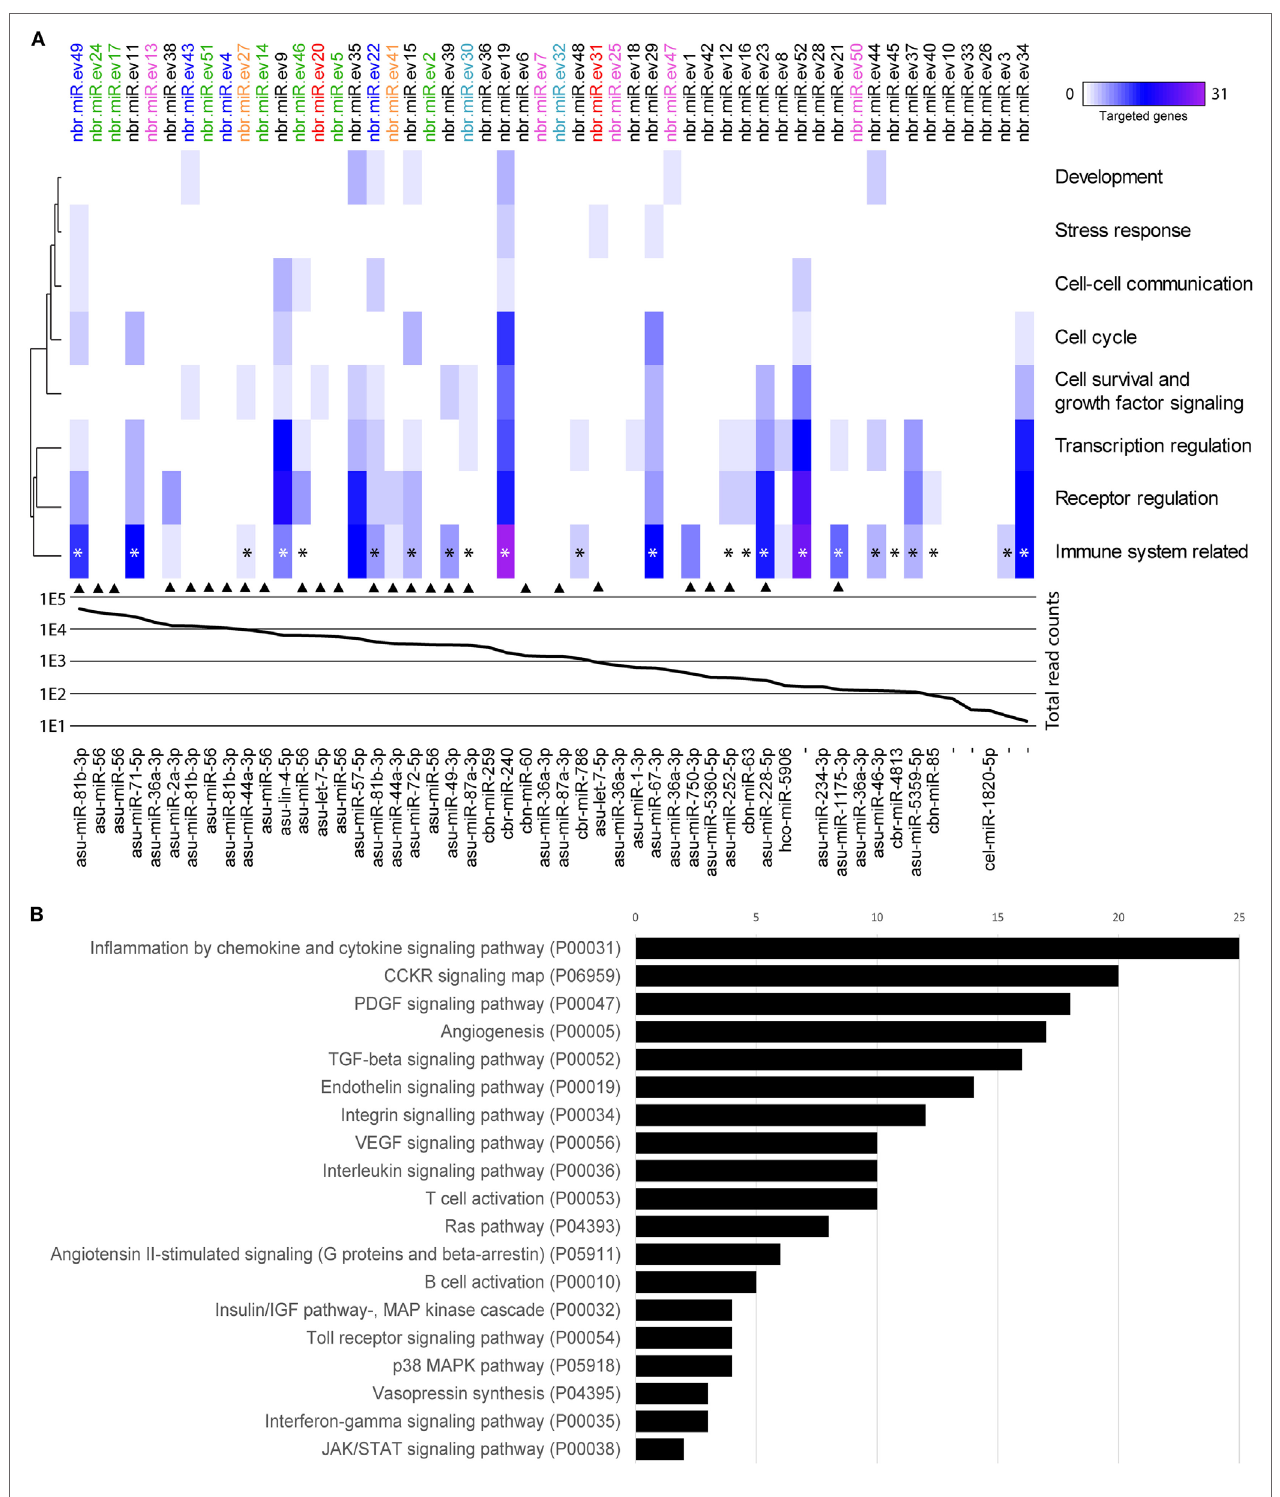
FigUre 6 | miRNAs of Nippostrongylus brasiliensis extracellular vesicles (EVs) are predicted to interact with different murine host gene networks. (a) Functional map of N. brasiliensis EV miRNAs and their target murine host genes categorized by PantherDB signaling pathway analysis (heat map corresponds to individual targeted genes in the murine host). Top axis shows the 52 identified miRNAs (termed as nbr-miR-ev#). IsomiRs are indicated in color. Graph represents the abundance (mean read counts from three biological replicates). Bottom axis shows their closest homologs ( de novo transcripts are left empty). Homologs to miRNAs found in Trichuris muris EVs are marked by an arrow [according to Eichenberger et al. (37)]. * indicates miRNAs targeting genes involved in cytokine networks. (B) Total number of targeted gene networks identified by PantherDB categories classified as “immune system related.” Data are available in Table S3 in Supplementary Material.